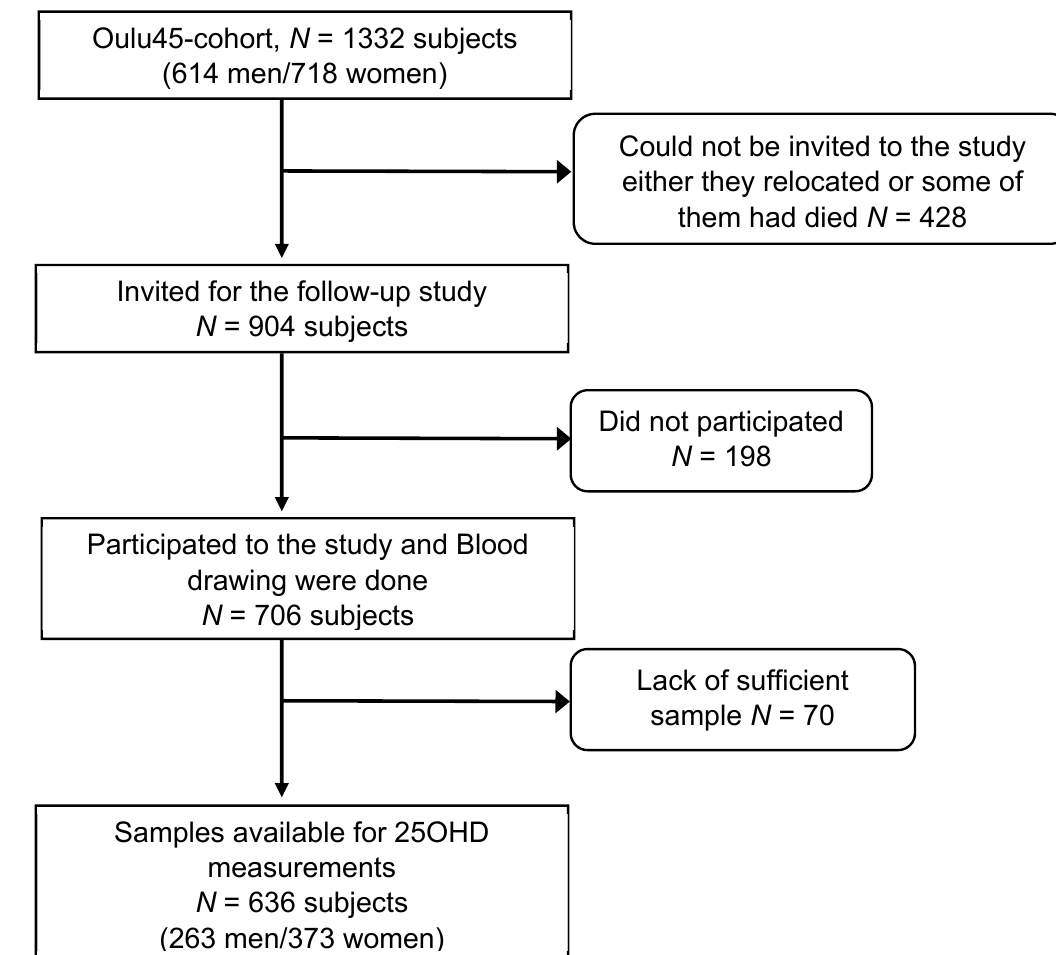
Figure 1. Flow chart of the study.